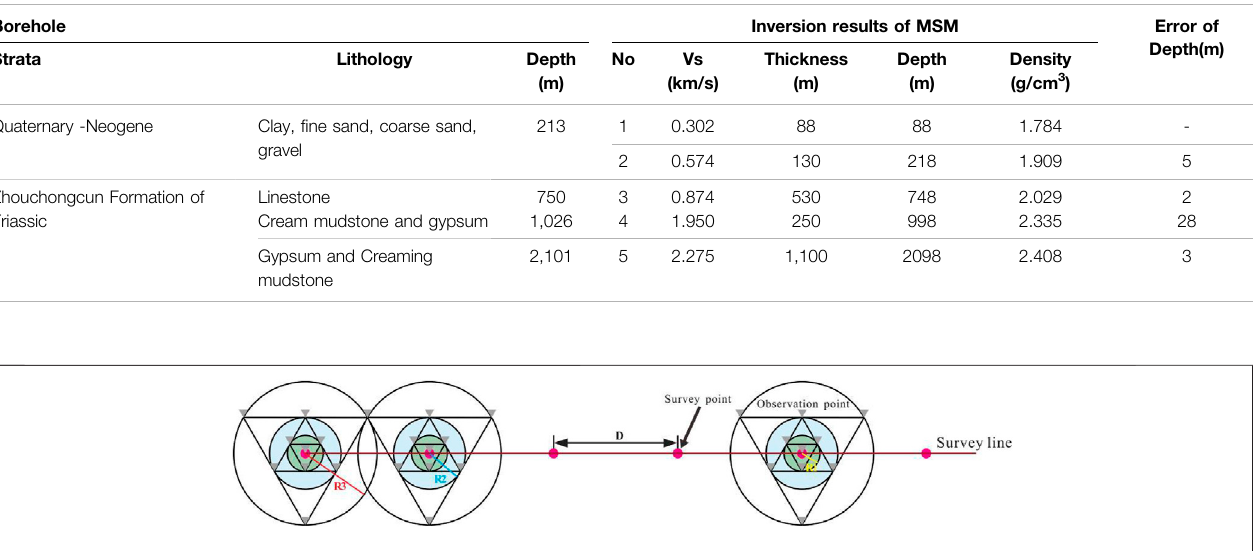
FIGURE 4 | Observation system for a microtremor survey line. In this fi gure, R represents the observation radii and D represents the distance between two survey points.